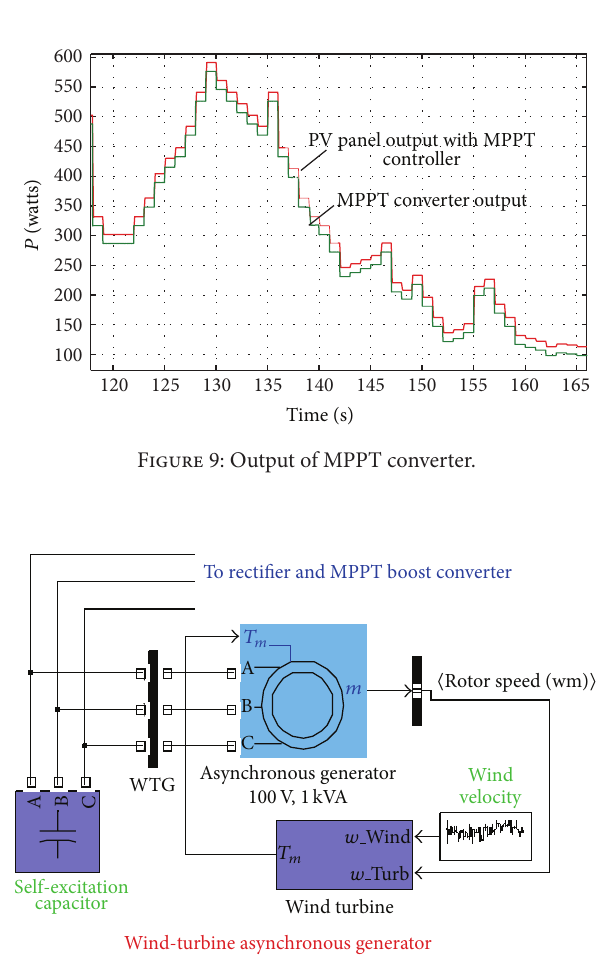
Figure 10: Wind turbine generator.